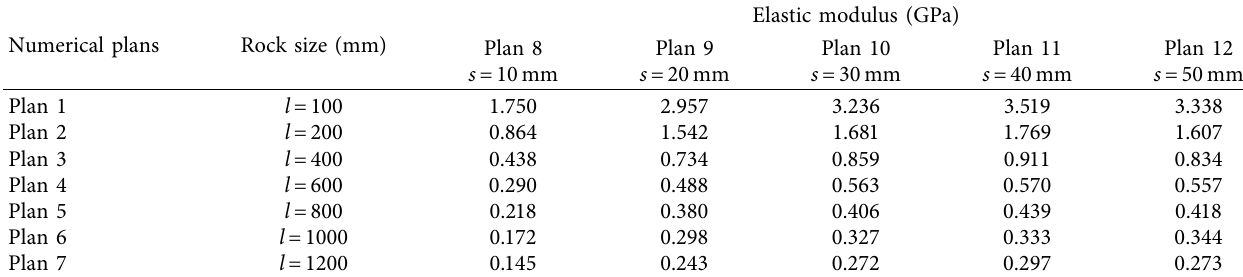
Figure 2: Stress-strain curves of rocks with different PJS. (a) s � 10mm, (b) s � 20 mm, (c) s � 30mm, (d) s � 40mm, and (e) s � 50mm. Table 2: Values of elastic modulus.